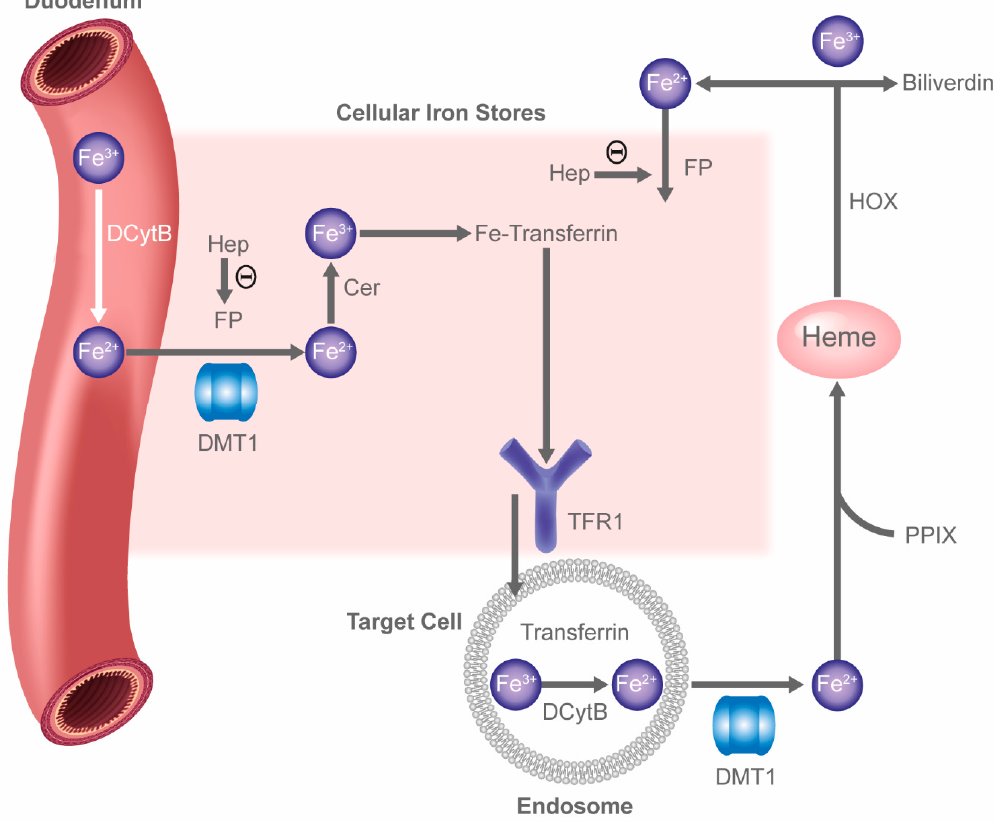
Figure 2. Iron handling. Cer: ceruloplasmin; DCytB: duodenal cytochrome B; DMT1: divalent metal transporter 1; Fe: iron; Hep: hepcidin; HOX: heme oxygenase; FP: ferroportin; PPIX: protoporphyrin IX; TFR: transferrin receptor. Θ represents a negative effect. Reprinted by permission of the publisher Taylor & Francis Ltd. (http:/www.tandfonline.com), from Muchnik & Kaplan [79].